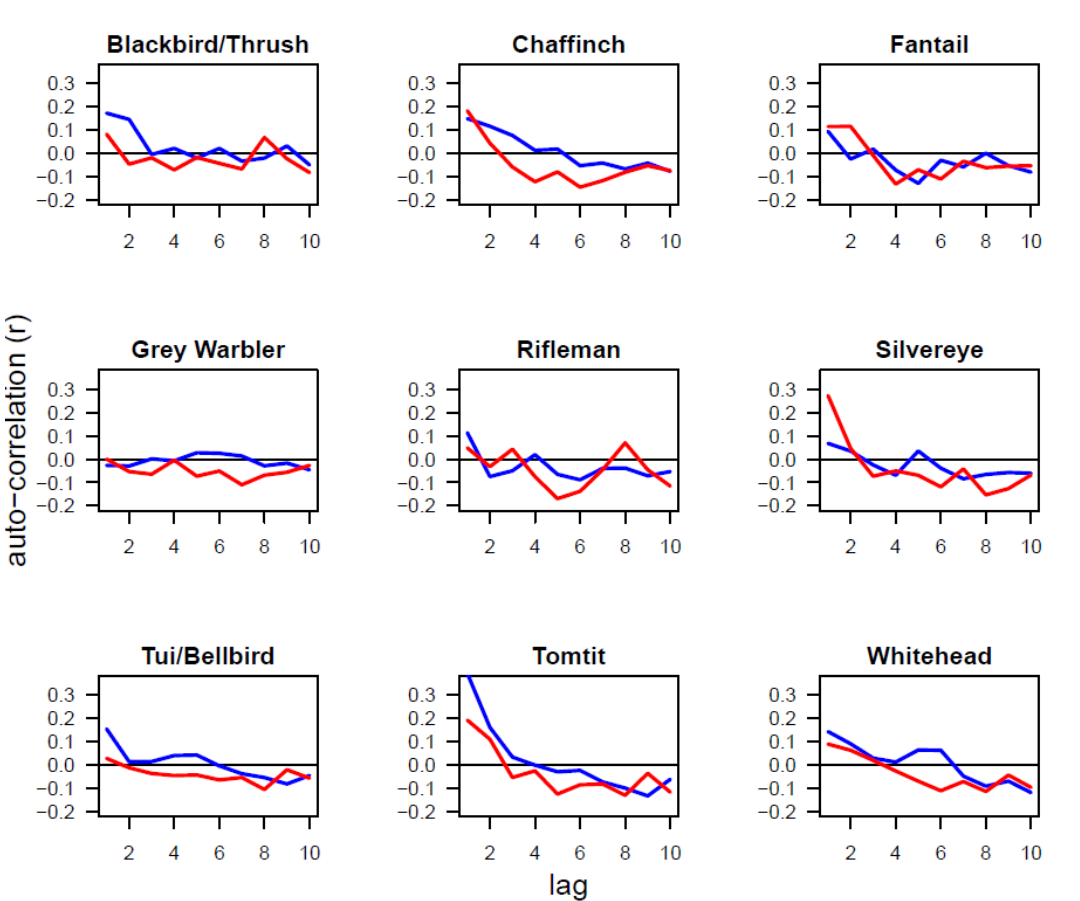
Figure A1.2: Mean temporal autocorrelation ( r ) for lags 1 to 10, for nine bird taxa sampled with two different presence-absence manual bioacoustic scoring methods. The continuous sampling method (red line) used a chronologically continuous five-minute subsets of 30- minute audio recordings, the intermittent method (blue line) used the first 10 seconds of every minute to create a non-continuous five minute subset of the original recoding. In both methods presence/absence was scored in ten-second blocks. Audio recordings were taken from 10 forest sites across the lower North Island, New Zealand. Only recordings with greater than 1 and less than 29 presences (out of 30) were included in the calculation of